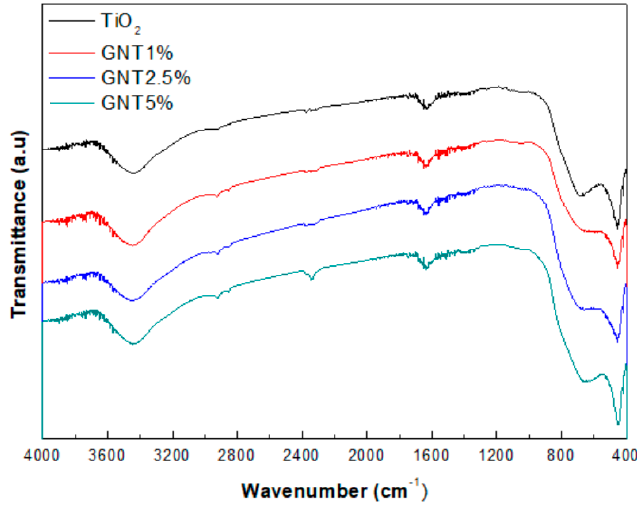
/ g-C Figure 2. spectra of TiO 2 /g-C 3 N 4 fibers after calcination. Figure 2. Spectra of TiO 2 3 N 4 fibers after Figure 2. spectra of TiO 2 /g-C 3 N 4 fibers after calcination.